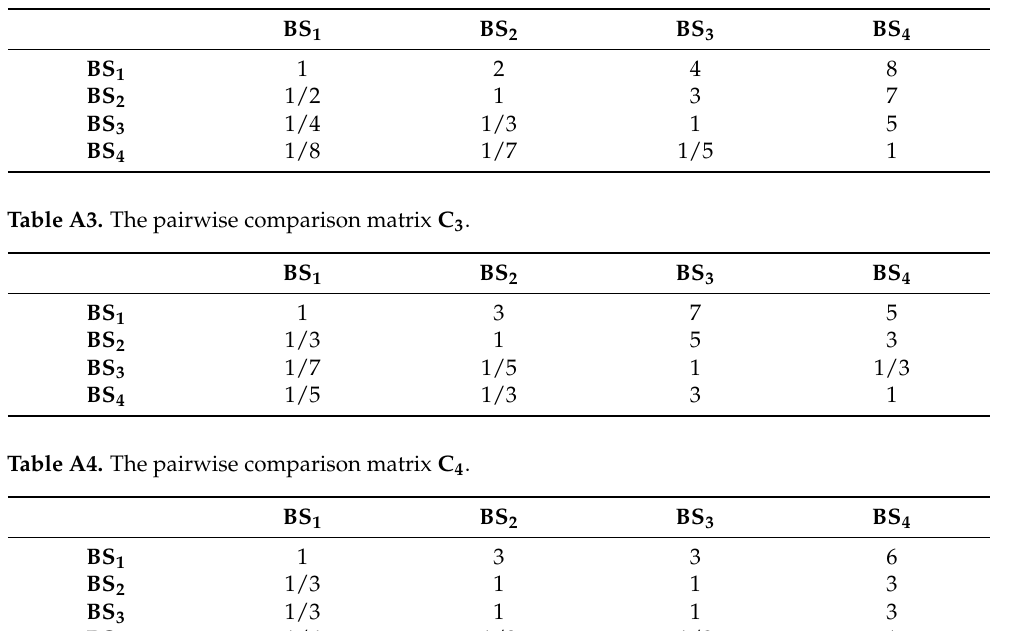
Table A2. The pairwise comparison matrix C 2 .